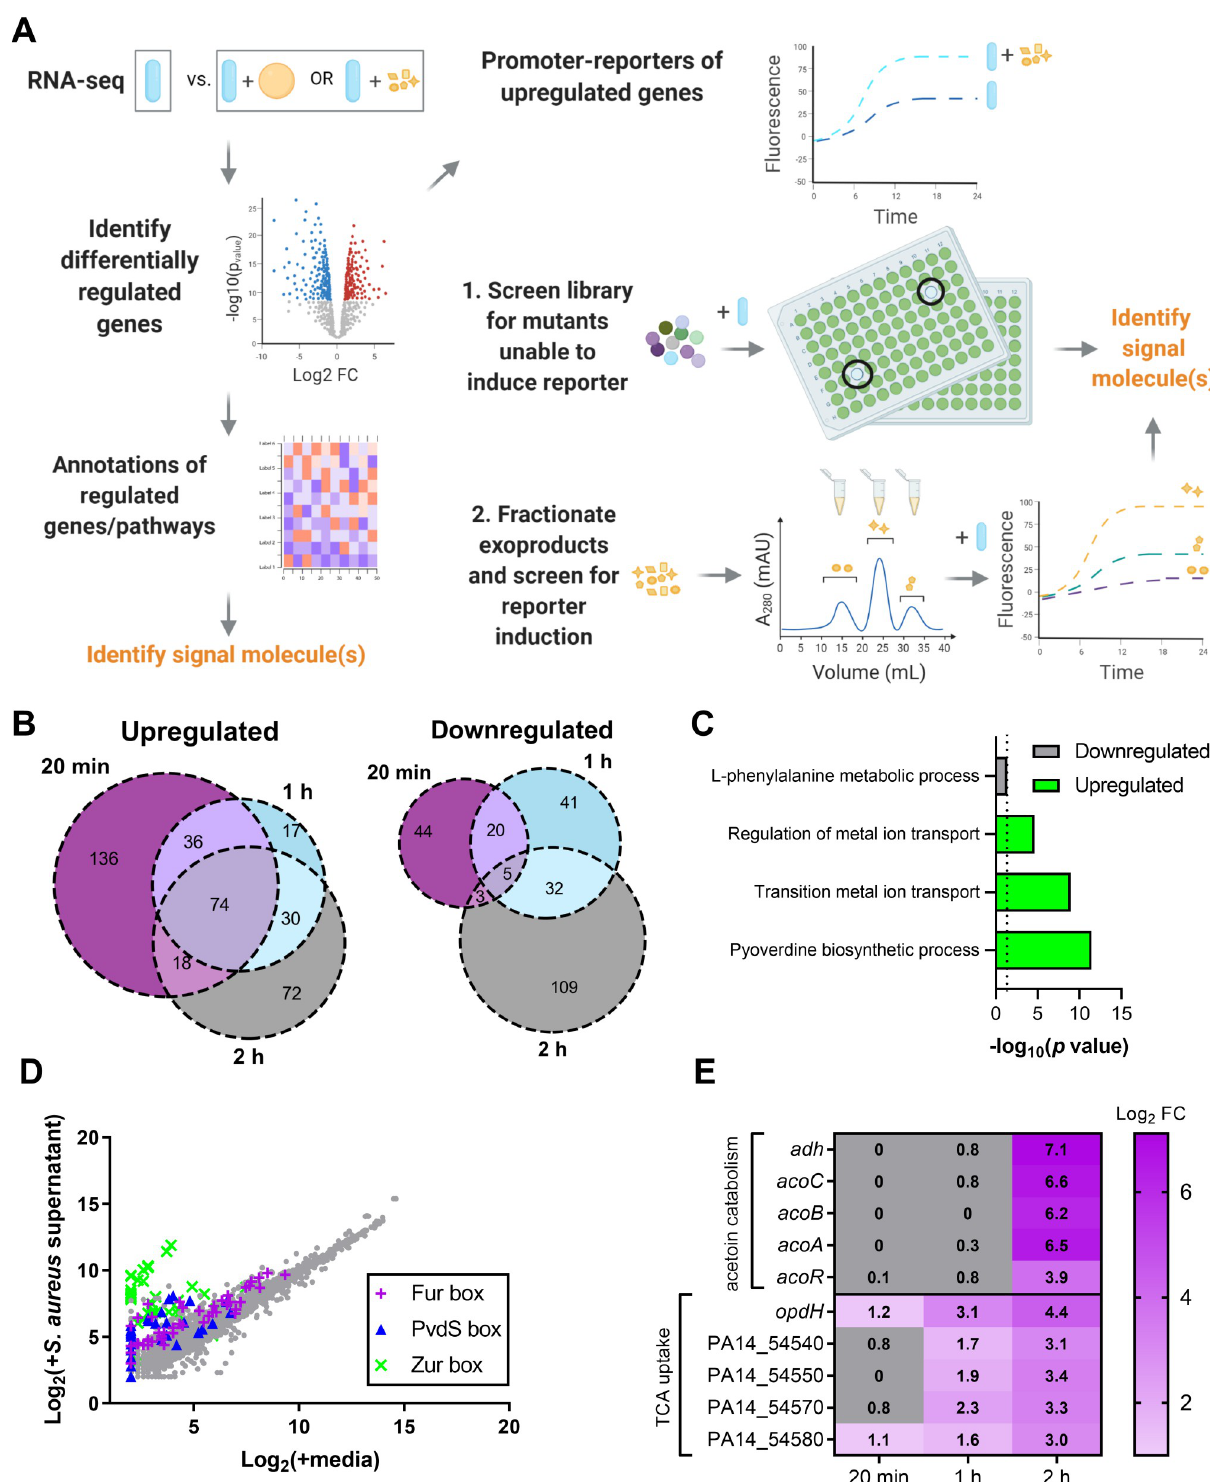
Fig 1. P . aeruginosa differentially regulates metal deprivation and intermediate metabolite uptake pathways in the presence of S . aureus supernatant. (A) Schematic for identification of molecular mediators of interspecies sensing in a two species system. Global transcriptional response of one species to another species, or its secreted exoproducts, compared to monocultures, is determined by RNA-seq. Analysis of the differentially regulated genes and pathways may be used to identify the signaling molecules that are sensed. Promoter-reporters are constructed from representative